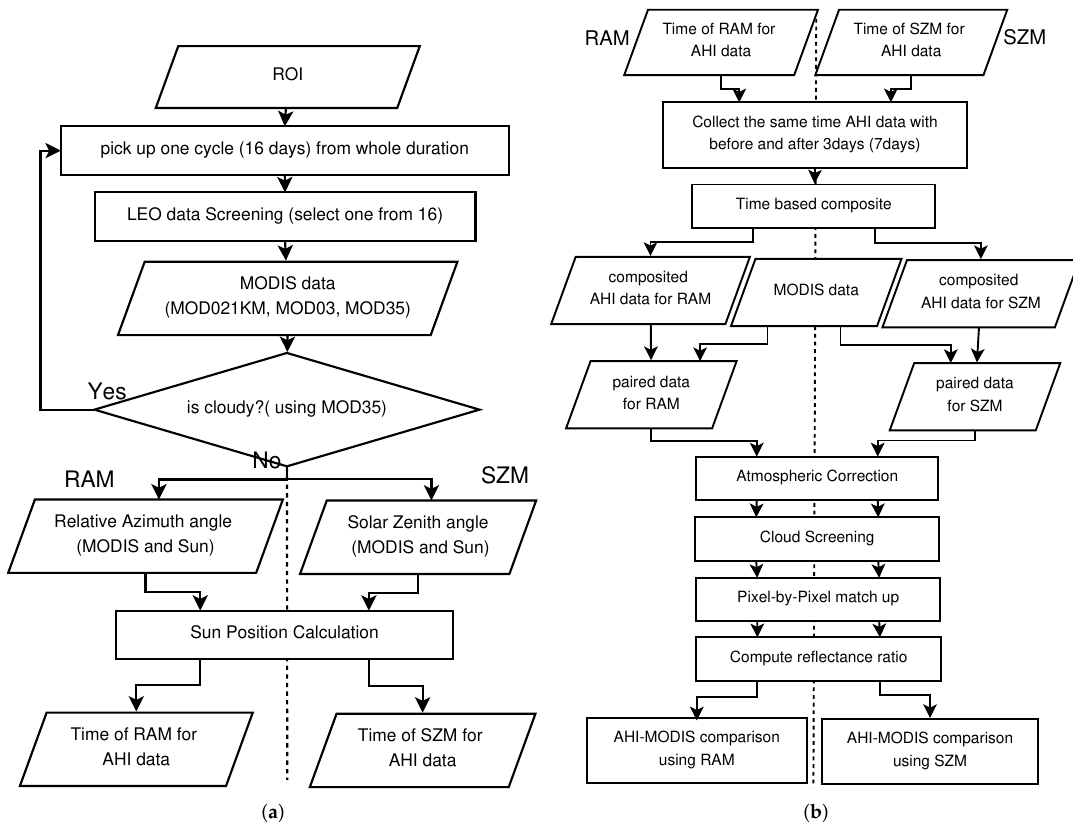
Figure 4. Flow chart describing the algorithm used for GEO-LEO reflectance comparisons (AHI and MODIS); ( a ) geometric condition retrieval; and ( b ) preprocessing, screening, and subsequent processing for